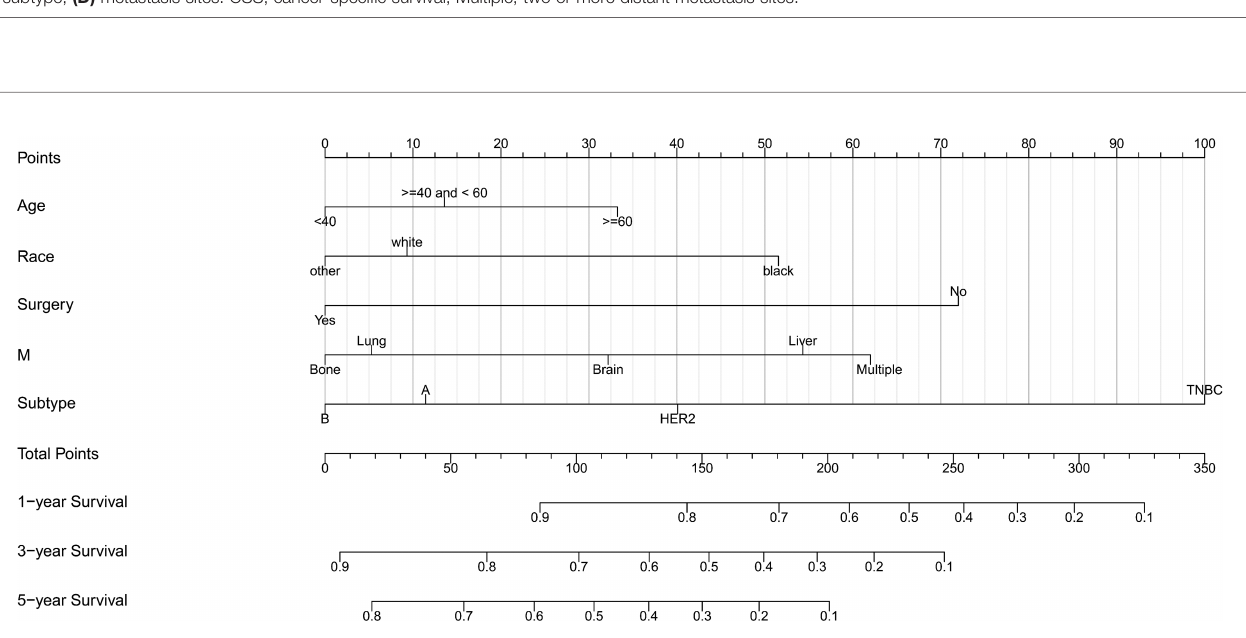
FIGURE 2 | The KM survival curves for predicting the CSS of lymph-node-negative women with DM. (A) Surgical intervention; (B) age at diagnosis; (C) breast subtype; (D) metastasis sites. CSS, cancer-speci fi c survival; Multiple, two or more distant metastasis sites.